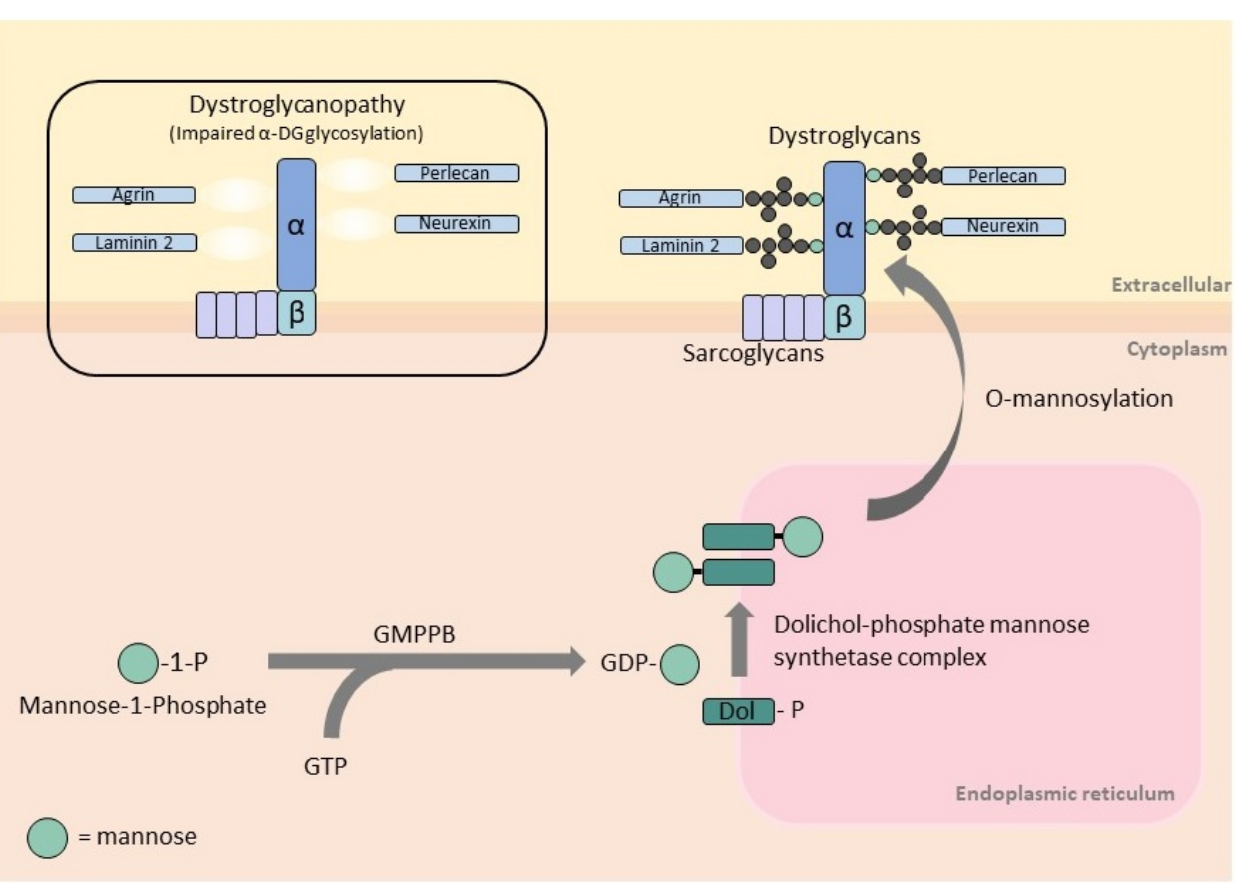
Figure 1. Schematic representation of GMPPB function in the O-mannosylation pathway and its association with α-dystroglycan. GMPPB catalyzes the formation of GDP-mannose from GTP and mannose-1-phosphate. GDP-mannose is the substrate of cytosolic mannosyltransferases required for the synthesis of dolichol-phosphate mannose, which is the essential mannose donor for O-mannosylation, a process required for the glycosylation of α -dystroglycan. Dystrophin– glycoprotein complex is linked to extracellular proteins (laminin 2, agrin, neurexin, perlecan, etc.) via glycans attached to α -dystroglycan. Impaired α -dystroglycan glycosylation disrupts the link to these extracellular proteins resulting in dystroglycanopathy/muscular